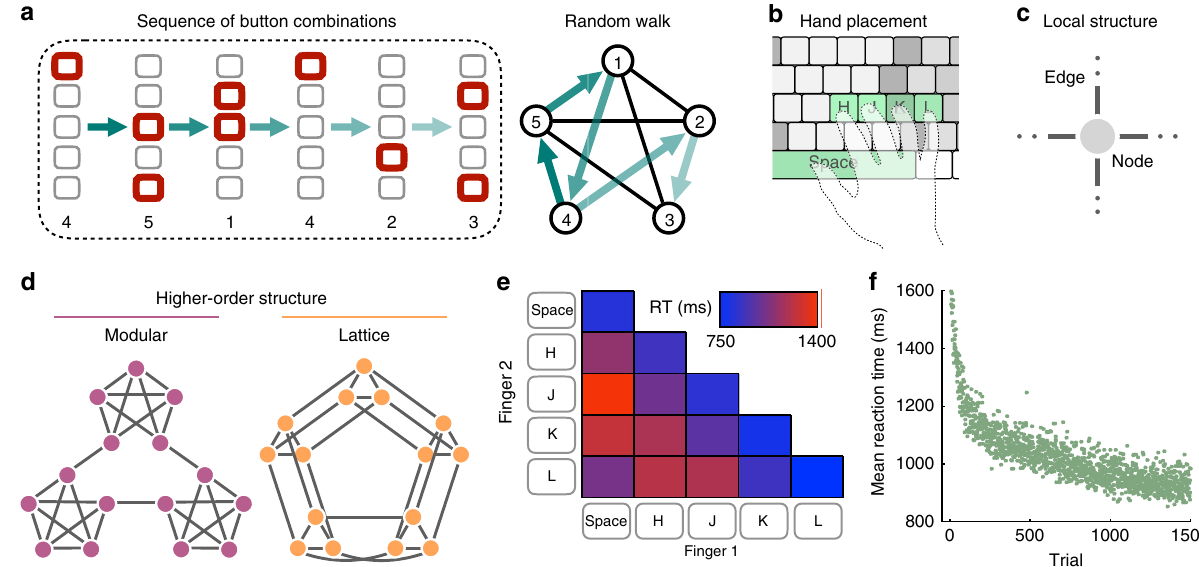
Fig. 1 Subjects respond to sequences of stimuli drawn as random walks on an underlying transition graph. a Example sequence of visual stimuli (left) representing a random walk on an underlying transition network (right). b For each stimulus, subjects are asked to respond by pressing a combination of one or two buttons on a keyboard. c Each of the 15 possible button combinations corresponds to a node in the transition network. We only consider networks with nodes of uniform degree k = 4 and edges with uniform transition probability 0.25. d Subjects were asked to respond to sequences of 1500 such nodes drawn from two different transition architectures: a modular graph (left) and a lattice graph (right). e Average reaction times for the different button combinations, where the diagonal elements represent single-button presses and the off-diagonal elements represent two-button presses. f Average reaction times as a function of trial number, characterized by a steep drop-off in the fi rst 500 trials followed by a gradual decline in the remaining 1000 trials. In e and f , averages are taken over responses during random walks on the modular and lattice graphs. Source data are provided as a Source Data fi